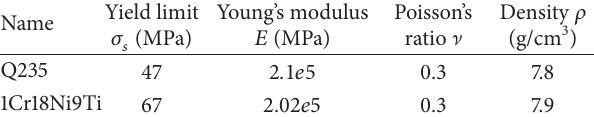
Table 1: The material constants of the double layer on 1150 ∘ C.